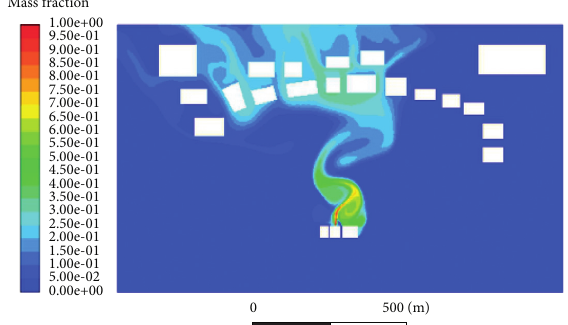
Figure 13: Radionuclide distribution rotating 270 ° clockwise at the southern break.